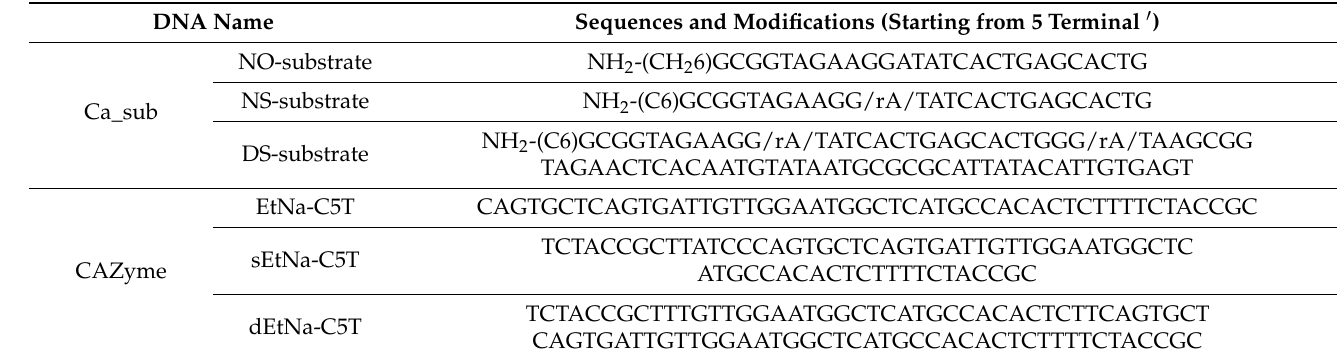
Table 1. Sequences of the modified DNA. DNA Name Sequences and Modifications (Starting from 5 Terminal (cid:48)